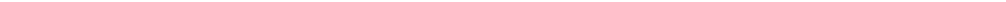
(see fi gure on previous page) Fig. 2 PRDX1 inhibits NOXA-dependent apoptosis of CRC cells. A Comparison of PRDX1 expression in different CRC cell lines (DLD1, SW480, SW620, HT29, and HCT116) by WB analysis. The PRDX1 level in DLD1 cells was set as 1, and tubulin was used as the loading control. B Cell growth assay: After shRNA-mediated silencing of PRDX1, cells were seeded into 96-well plates (2000 cells per well) in triplicate and subjected to a CCK8 assay every 24 h for a duration of 120 h. The mean ± SD of four independent experiments is shown (* p < 0.05). C – E Clonogenic survival assay. After shRNA- mediated silencing of PRDX1, HCT116 ( C ), HT29 ( D ), and DLD1 ( E ) cells were seeded into 60-mm dishes (1000 cells per dish). After 2 weeks of incubation at 37 °C, colonies were stained with 0.1% crystal violet and counted. The mean ± SD of three independent experiments is shown (** p < 0.01, *** p < 0.001). F – H HCT116 ( F ), HT29 ( G ), and DLD1 ( H ) cells stained with 7-AAD and PE were analyzed by fl ow cytometry to detect apoptosis induced by shRNA-mediated silencing of PRDX1 in CRC cell lines. The mean ± SD of three independent experiments is shown (** p < 0.01, *** p < 0.001). I PRDX1 knockdown induced apoptosis in CRC cells: cells infected with lentivirus expressing the indicated shRNAs were subjected to WB analysis with β -actin as the loading control. J The expression of NOXA but not BCL2 or BAX was changed upon PRDX1 silencing in HCT116 cells or PRDX1 overexpression in SW480 cells. Cells transduced with the indicated lentiviral vectors were subjected to WB analysis. K , L Apoptosis caused by knockdown of PRDX1 was suppressed by NOXA silencing. HCT116 cells infected with lentivirus expressing the indicated shRNAs were transfected with si-Ctrl and si-NOXA for 48 h prior to fl ow cytometry ( K ) and WB analysis ( L ). The NOXA protein and apoptosis markers (cleaved PARP and cleaved caspase-3) were analyzed. The mean ± SD of three independent experiments is shown (*** p < 0.001, ns: no signi fi cant difference).